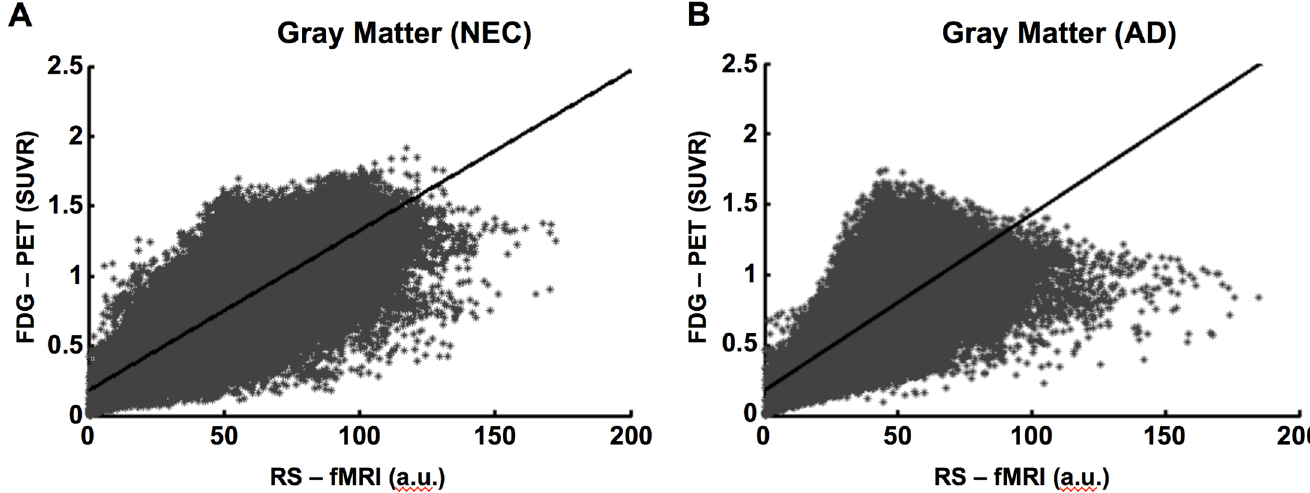
Fig 6. Relationship between glucose metabolism using FDG-PET and brain activity measuredby RS-fMRI. Voxel by Voxel correlationof pixel intensity in gray matter (r = 0.81, p < 0.001) from a healthyelderly subject (A) and a patient with Alzheimer disease(B) (r = 0.77, p < 0.001) betweenbrain activity using RS-fMRI and corrected glucosemetabolismusing FDG-PET SUVR.